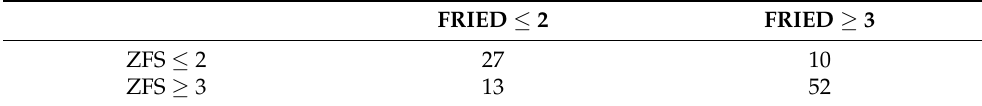
Table 12. Contingency study